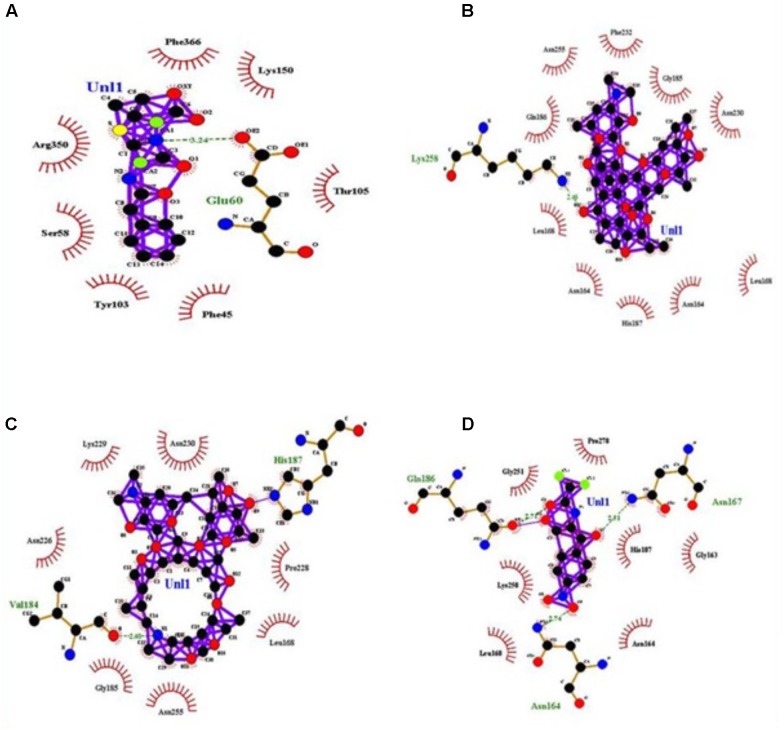
Docked complex showing interactions between cysteine protease with (A) Penicillin-G, (B) Azithromycin, (C) Erythromycin, (D) Chloramphenicol.